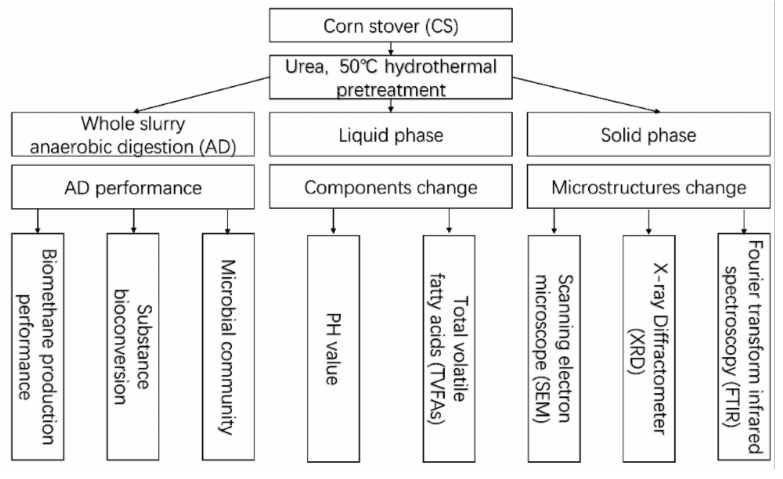
Figure 1. Flow chart of experimental